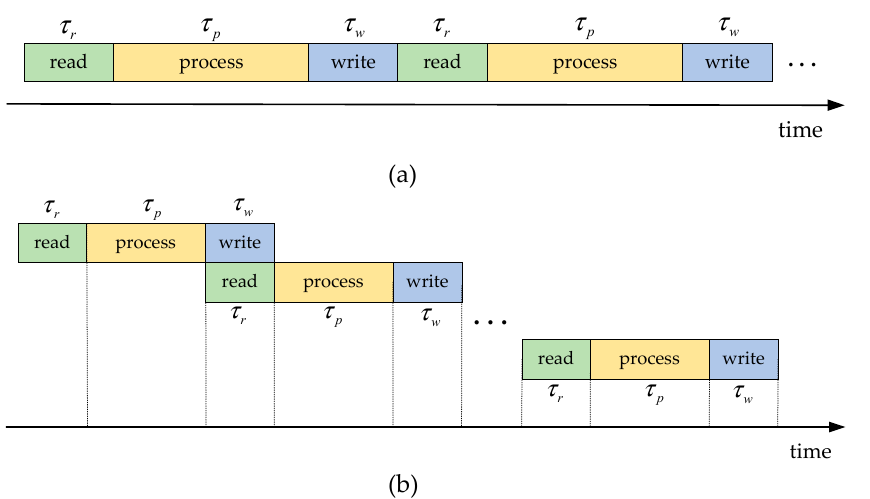
Figure 4. Sequence diagram of data processing. ( a ) The system has single-channel memory; ( b ) the system has dual-channel memory. Write operations and read operations can be completed in parallel.